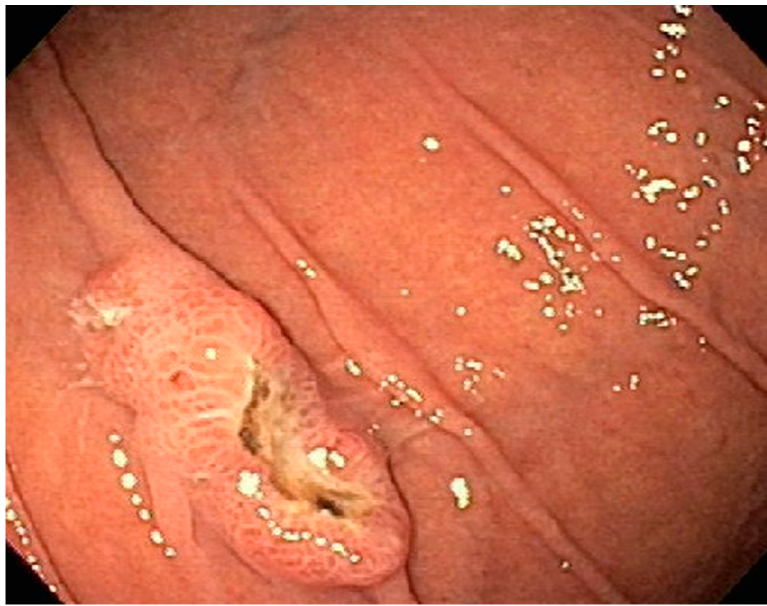
Figure 17. Large cratered ulcer seen in the gastric body.